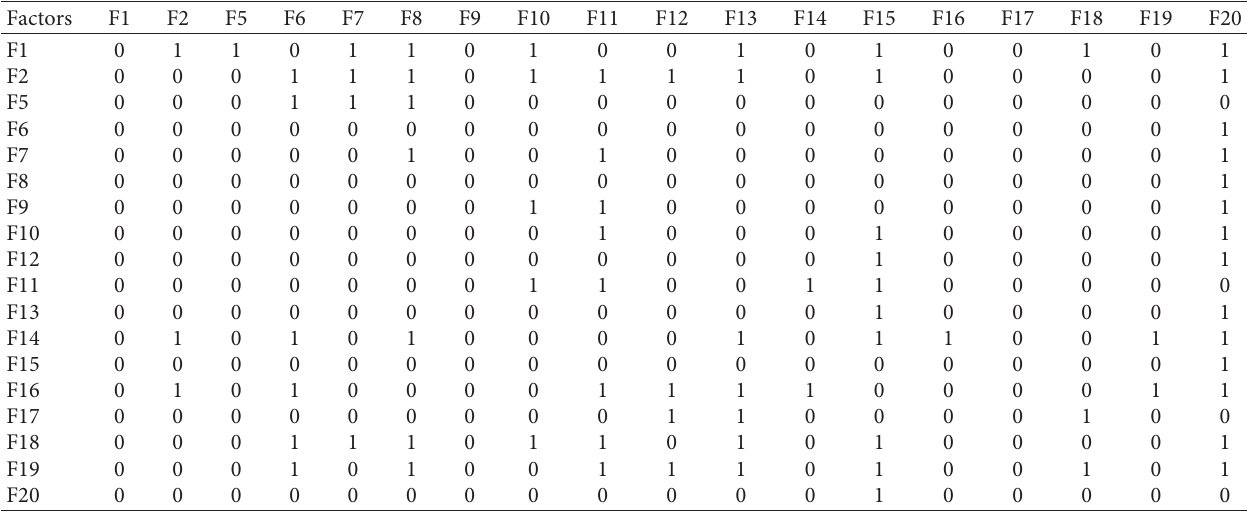
Table 4: Adjacency matrix of 18 key